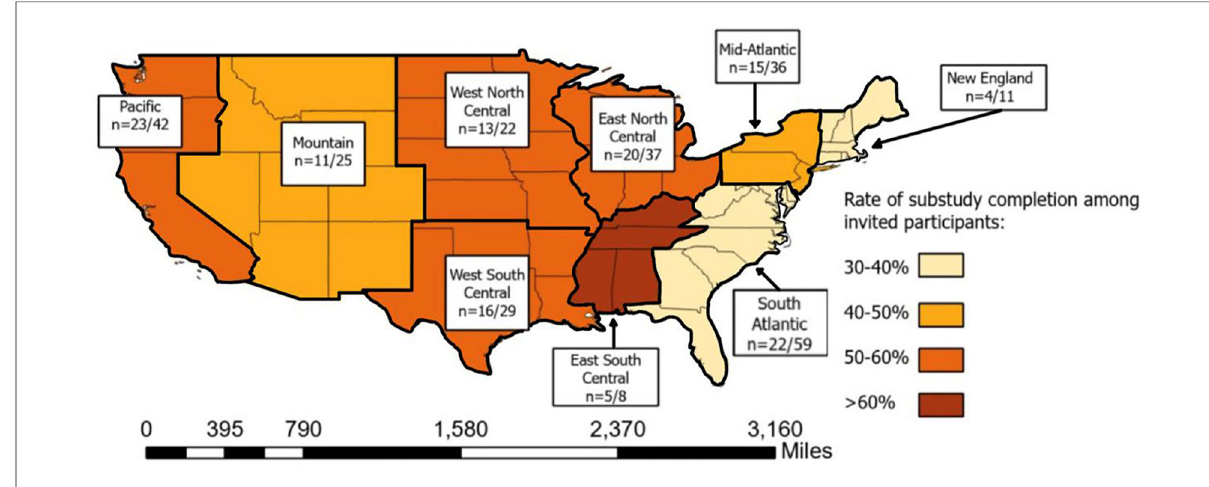
FIGURE 3 Density of participants completing the mail-based protocol across 9 geographic subregions of the United States of